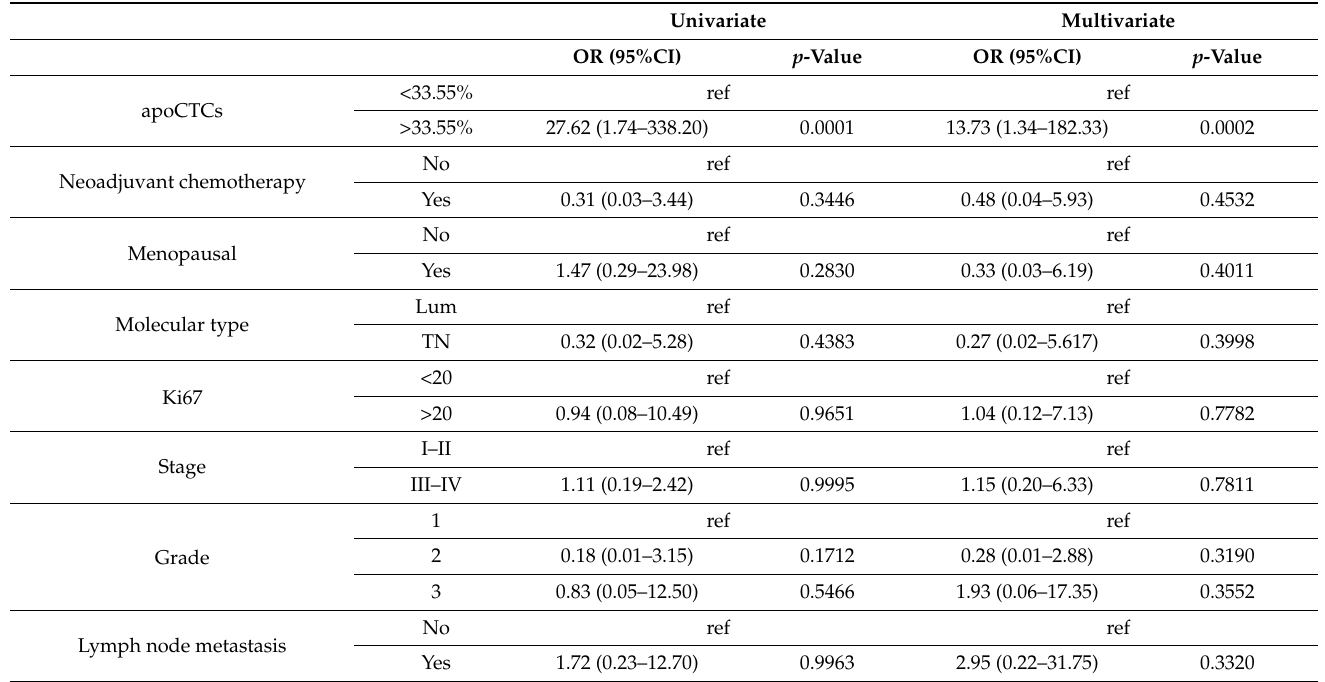
Table 2. The univariate and multivariate Cox regression analyses of metastasis-free survival rate for breast cancer patients.